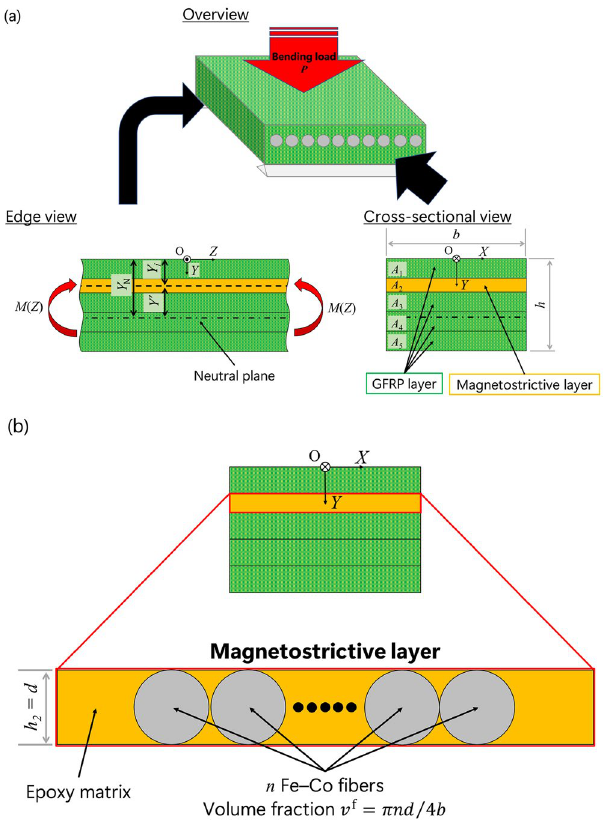
Figure 3. Image of a five layered composite beam with four GFRP layers and one magnetostrictive layer; ( a ) overview, edge view, and cross-sectional view, and ( b ) magnetostrictive